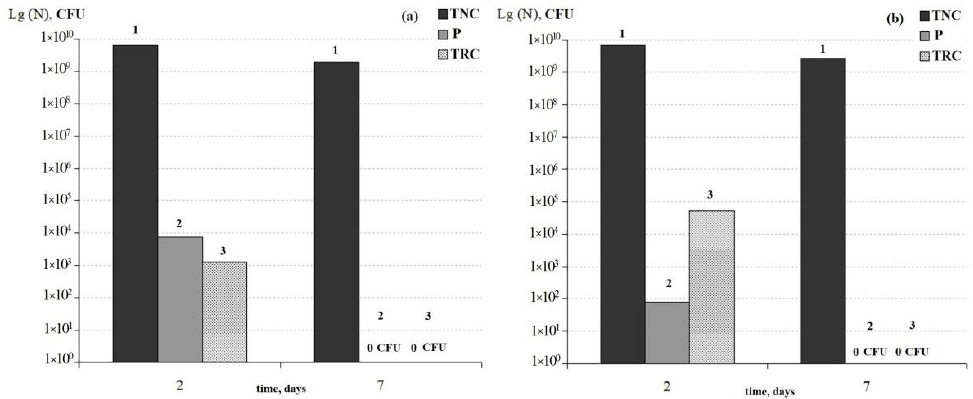
Figure 3. Changes in the total number (CFU/filter) of cells (TNC) (1), number of persisters (P) (2) and thermoresistant cells (TRC) (3) in the two-day and seven-day mono-species biofilms of P. antarctica ( a ) and P. extremorientalis ( b ).